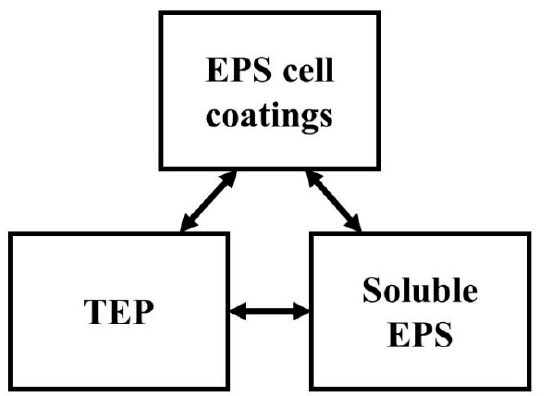
Figure 1. Dynamic relationship between the three pools of EPS. Arrows indicate possible conversions between the pools. The figure is from Thornton (2001) [18].